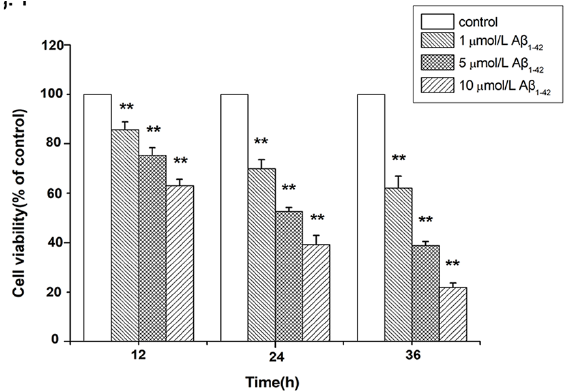
Figure 1. Cytotoxicity of Aβ on PC12 cells. A culture 1-42 media (1 μmol/L Aβ , 5 μmol/L Aβ and 10 μmol/L 1-42 1-42 Aβ ) was used to treat the PC12 cells for 12, 24 and 1-42 36 h. A CCK-8 assay was used to measure the viability Figure 2. Safety detection of triptolide. Different of the cells, while the outcomes were represented by concentrations of triptolide (10 -10 , 10 -9 , 10 -8 mol/L) was the absorbance percentage as compared to the control used to treat the PC12 cells for 24 h. A CCK-8 assay group. Data represent the mean ± S.E.M. n=6/group. was used to measure the viability of the cells. Data ** P < 0.01 vs. control group. represent the mean ± S.E.M.